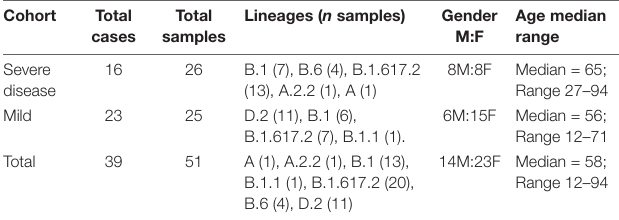
TABLE 1 | Demographics of SARS-CoV-2 positive cases within the severe and mild